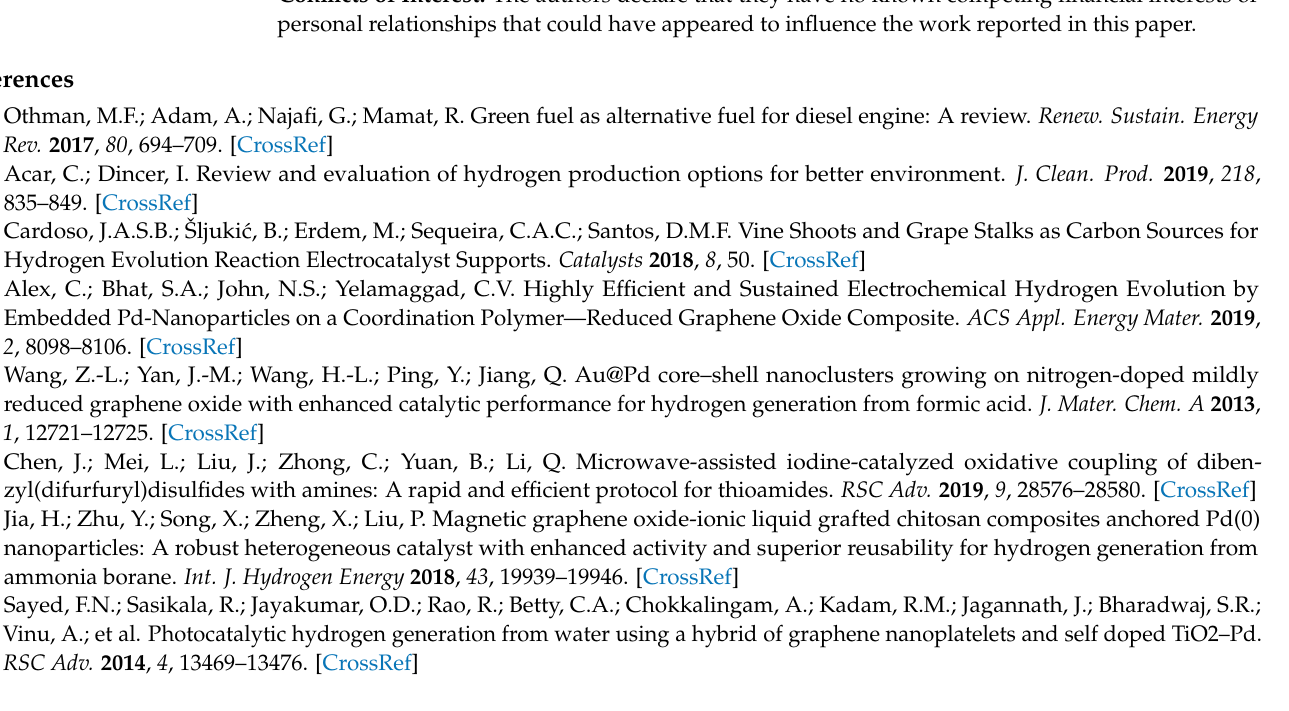
Figure S3: FT-IR analysis of recovered Pd@C-PS, Figure S4: GC spectrum of the produced gas mixture, Table S1: Comparison of TOFs obtained by various catalysts for FA